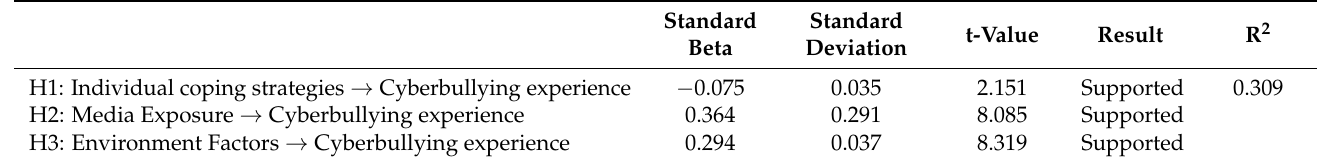
Table 4. Path significance and t values (Bootstrapping